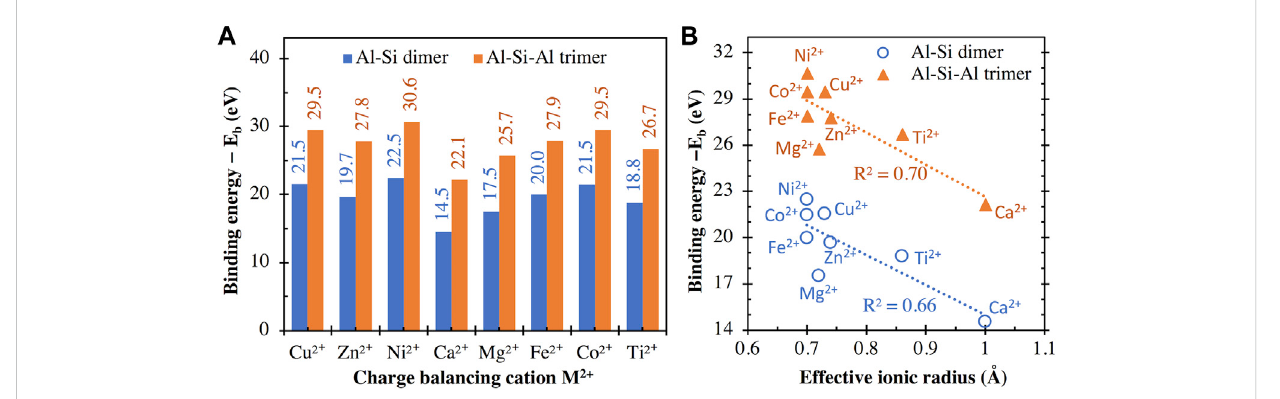
FIGURE 5 (A) Binding energies between (I) the aluminosilicate dimer (i.e., [(OH) 3 -Si-O-Al-(OH) 3 ] − 1 ) and trimer (i.e., [(OH) 3 -Al-O-(OH) 2 -Si-O-Al-(OH) 3 ] − 2 ) and (ii) different divalent cations, calculated using Eq. 1, with the total energies of individual components in Eq. 1 given in Supplementary Table S1. (B) Comparison of binding energies in (A) and the effective ionic radius (for VI-coordinated M 2+ ) of the divalent metal cations. R 2 values for linear regression are also given in (B) .